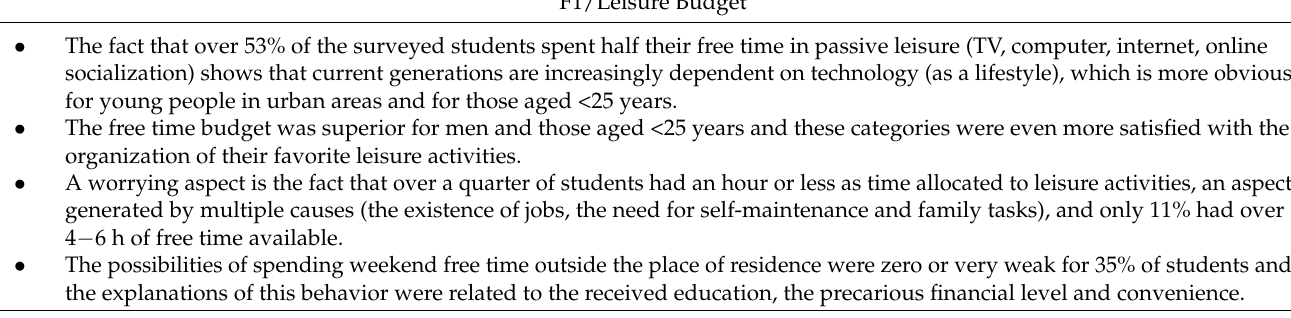
Table 10. Factor summary of research